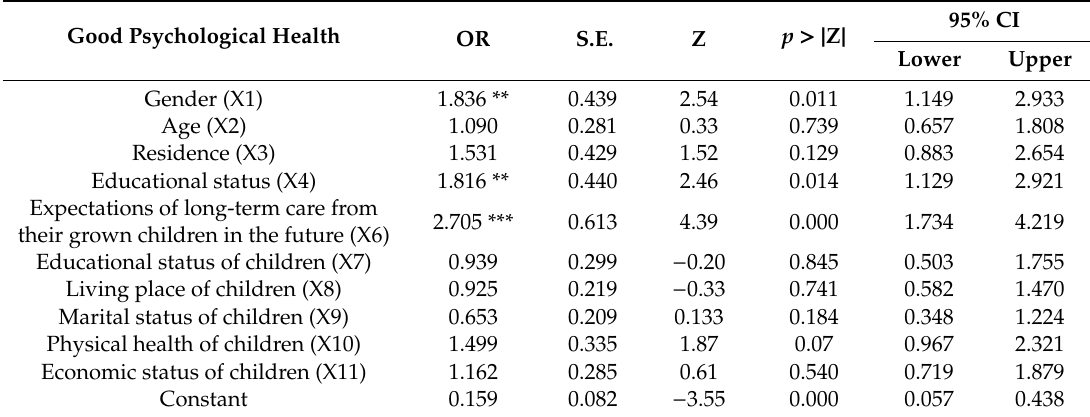
Table 3. Logistic regression results in the second